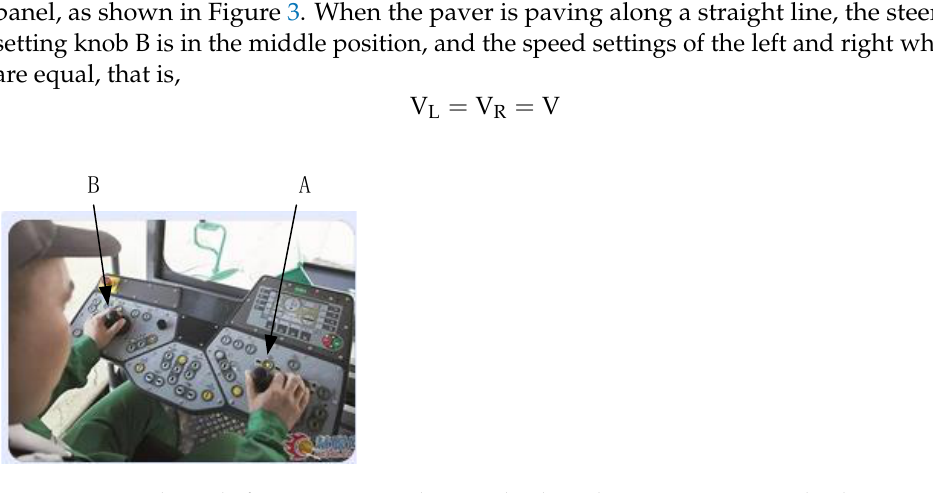
Figure 3. Control panel of paver. A — Speed setting knob, and B — Steering setting knob. According to the forward/backward switch on the control panel, the paver can move forward or backward along a straight line.